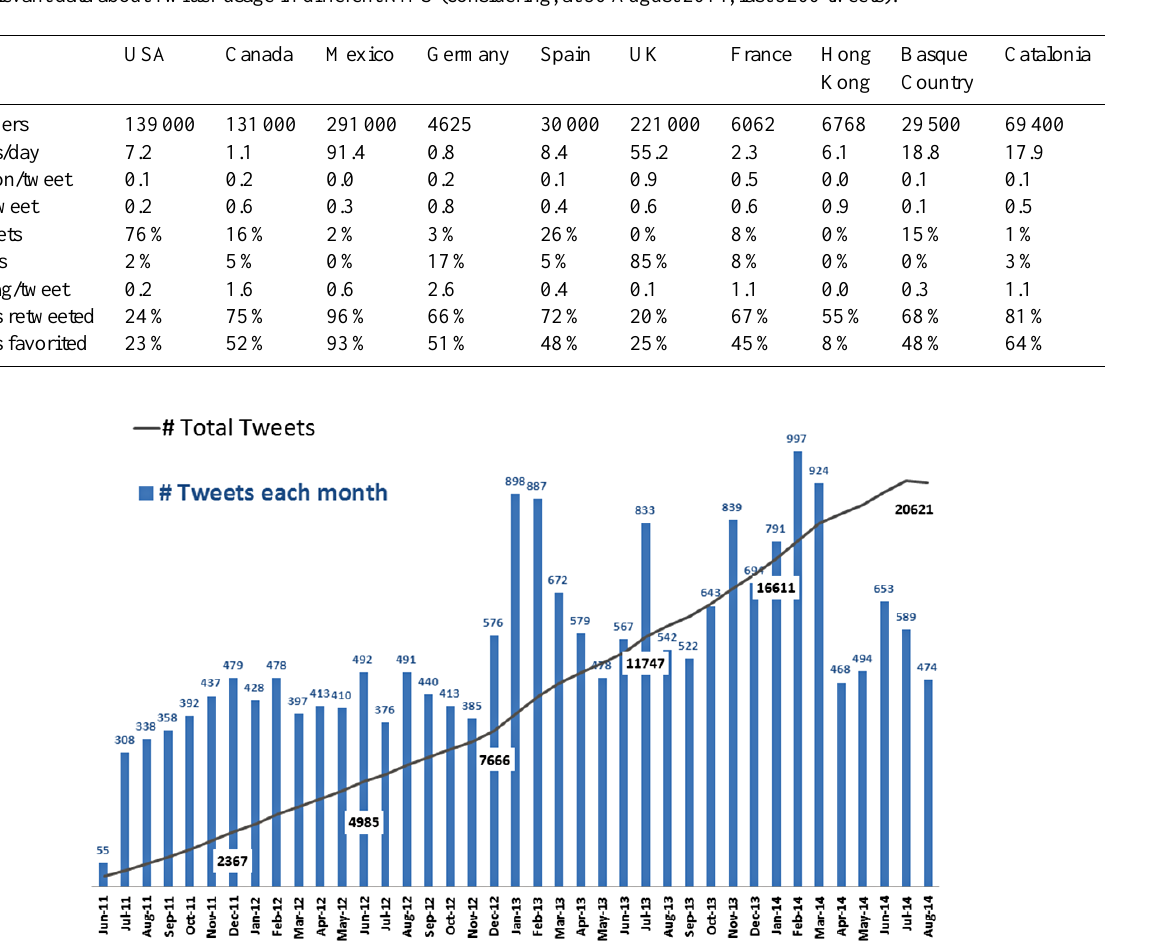
Table 1. Relevant data about Twitter usage in different NMS (considering, at 30 August 2014, last 3200 tweets).